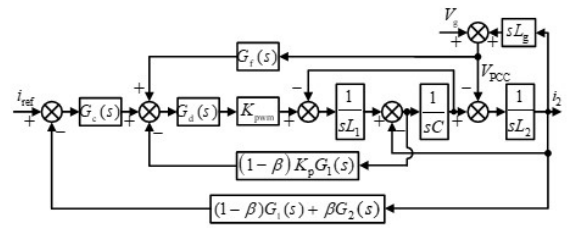
Fig. 10. Grid-connected inverter improved CCFAD control system structure